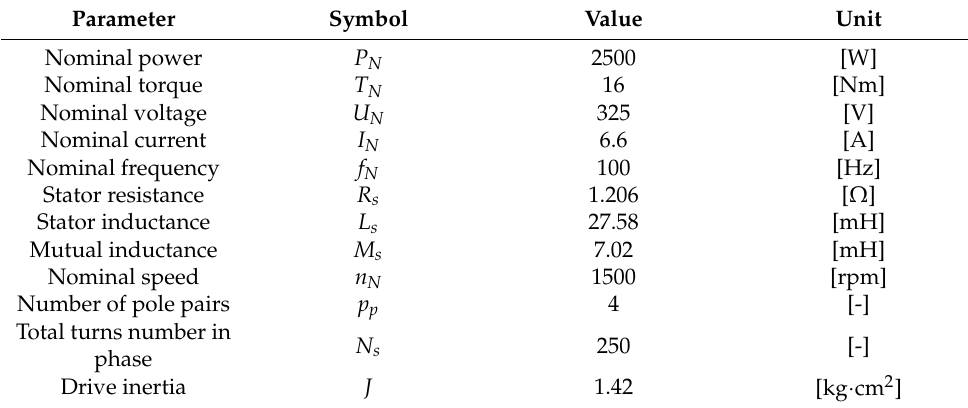
Table A1. The nominal parameters of the tested